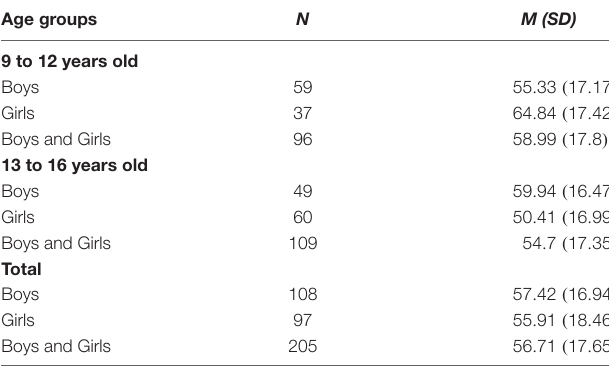
TABLE 7 | Mean and standard deviations of the latent emotion regulation variable by age group and gender. Age groups